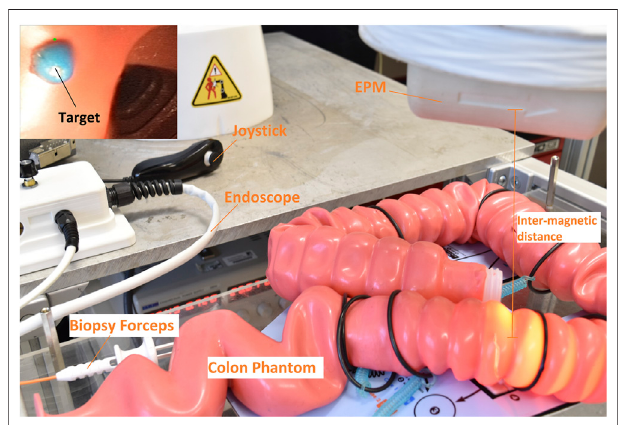
FIGURE 5 | Experimental setup. The overall system is composed by an EPM, which actuates the MFE (placed inside the colon simulator), and a joysticktosteertheendoscope.Onthetopleft,theon-boardcamerashowsa biopsy target inside a latex colonoscopy training phantom (M40, Kyoto Kagaku